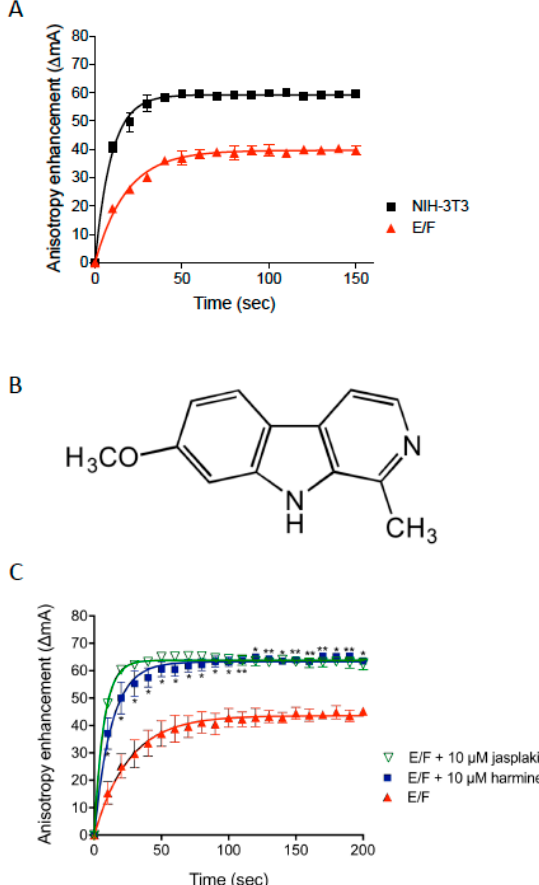
Figure 1. Effect of harmine on actin polymerization in EWS-FLI1 (E/F) cell extracts. ( A ) Kinetics of F-actin linear polymerization as measured in NIH-3T3 fibroblast and Ewing tumorigenic fibroblast (E/F) cell extracts using the fluorescence anisotropy assay. The results presented are means ± SEM for two independent experiments. ( B ) Chemical structure of harmine. ( C ) Kinetics of F-actin linear polymerization as measured in E/F cell extracts using the fluorescence anisotropy assay. Ten micromoles Jasplakinolide (green curve), 10 µM harmine (blue curve) or vehicle (red curve) are added, at time 0, to the polymerization buffer, actin-Alexa488 and E/F extracts. Actin polymerization was measured at different incubation times using fluorescence anisotropy assay. The results presented are means ± SEM for three independent experiments. * p < 0.05; ** p < 0.01 harmine-treated versus control untreated E/F cells.